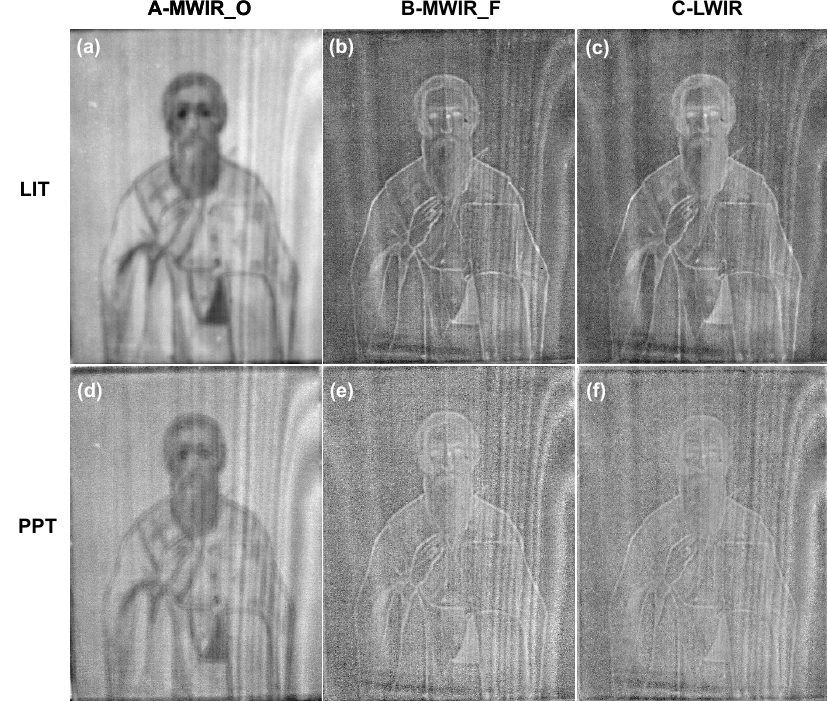
Figure 6. LIT and PPT phase images of the St. Nicholas icon for all camera setups. By eliminating the influence of the reflections, we can clearly visualize the pencil drawing ( b , c , e , f ). In the LIT phase images ( a – c ) the pencil drawing and smaller surface defects have a higher contrast, and the images appear less noisy overall, when compared to the PPT phase images ( d – f